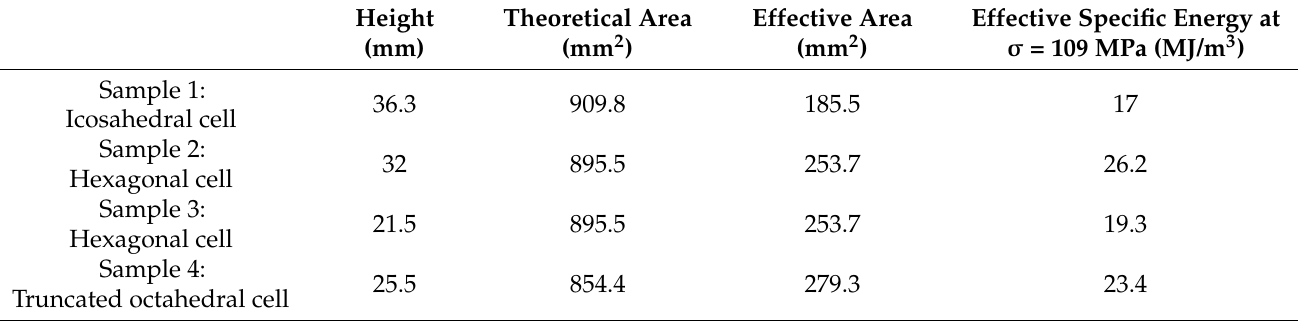
Figure 11. Stress–strain curves for icosahedral (1), hexagonal (2), hexagonal (3) and truncated octahedron (4).